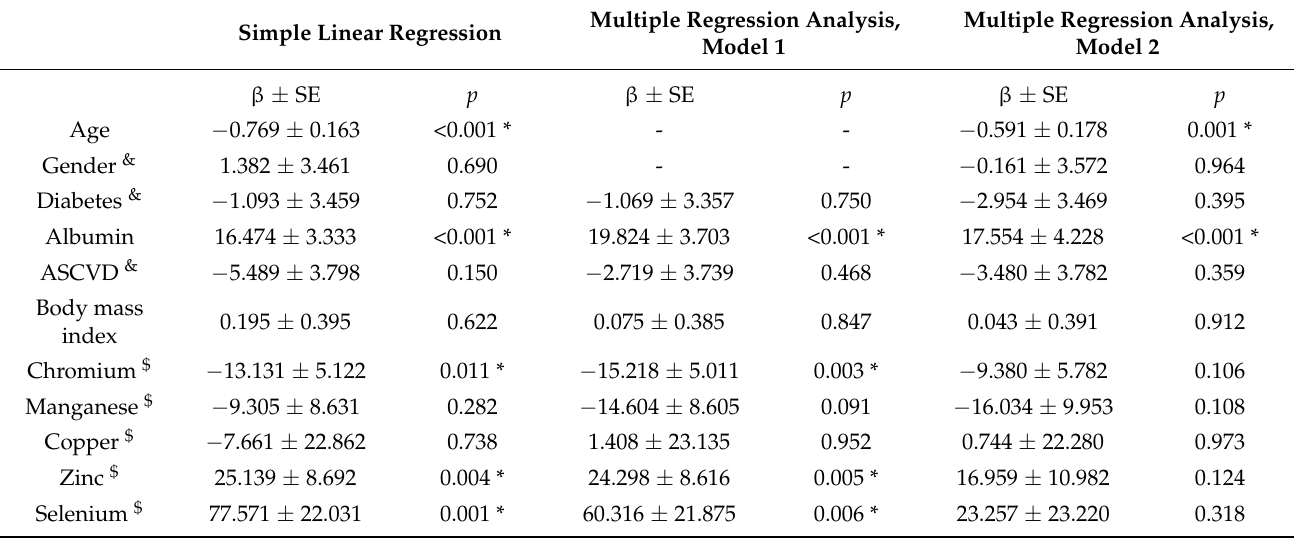
Table 3. β -coefficient between eGFR and independent